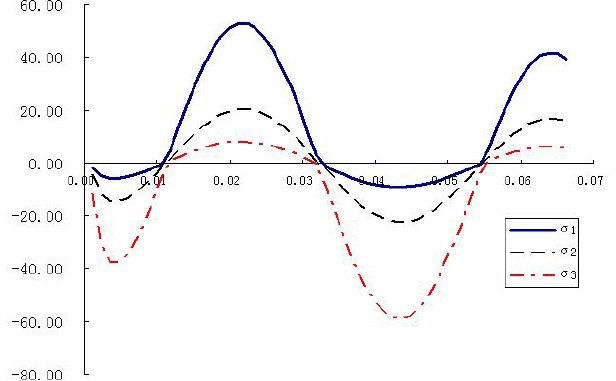
Figure 4. Time series curve of typical principal stress.